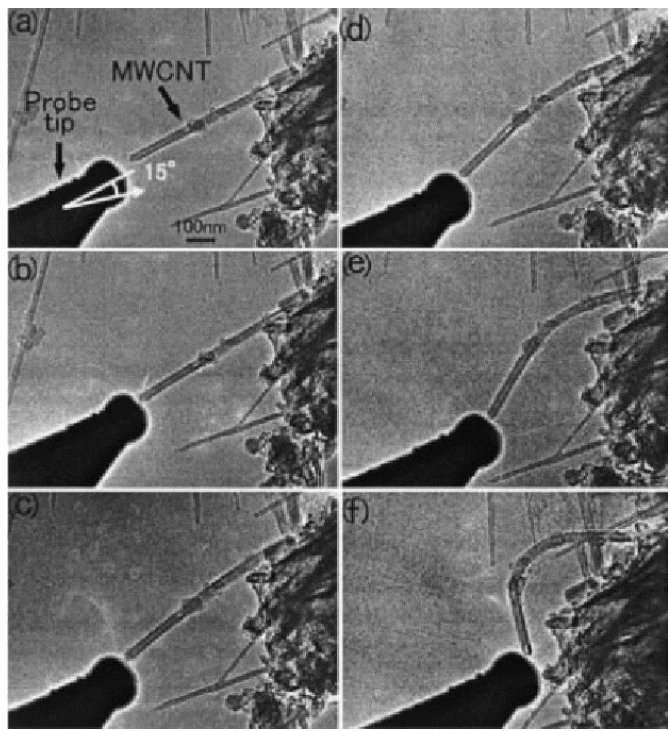
Figure 14. Series of TEM images of deformation processes for MWNTs initiated by applying compressive force in the sample direction. Adapted with permission from [62], Copyright MDPI, 2012.